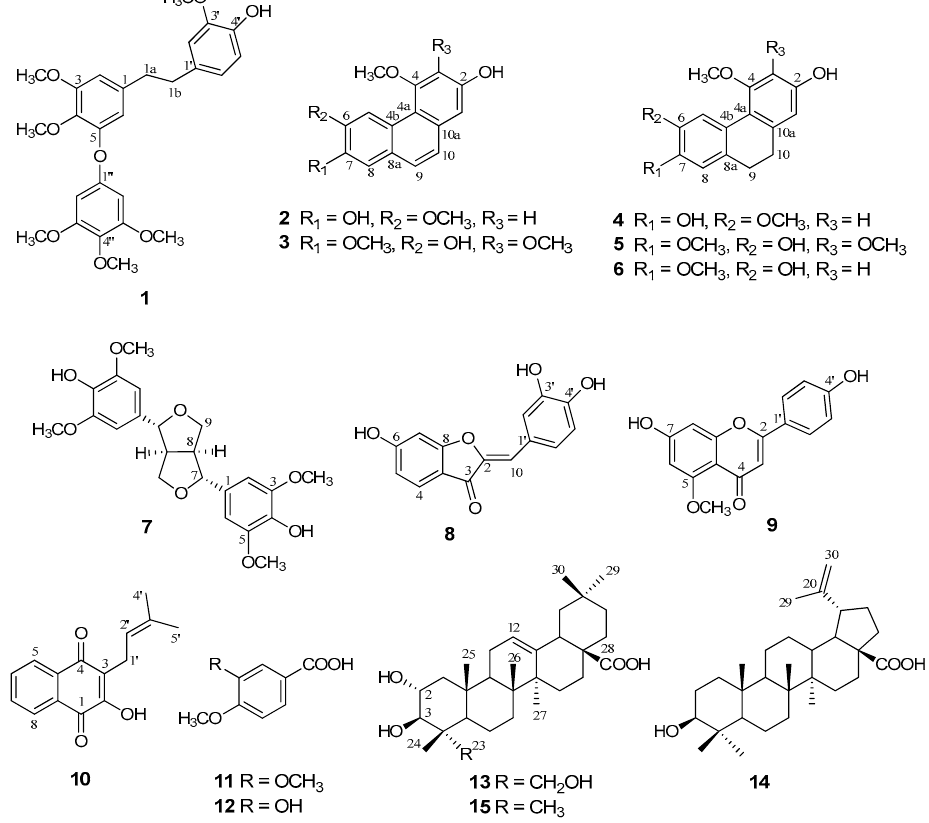
Figure 1. Structures of compounds ( 1 – 15 ) isolated from the roots and stems of Combretum laxum .